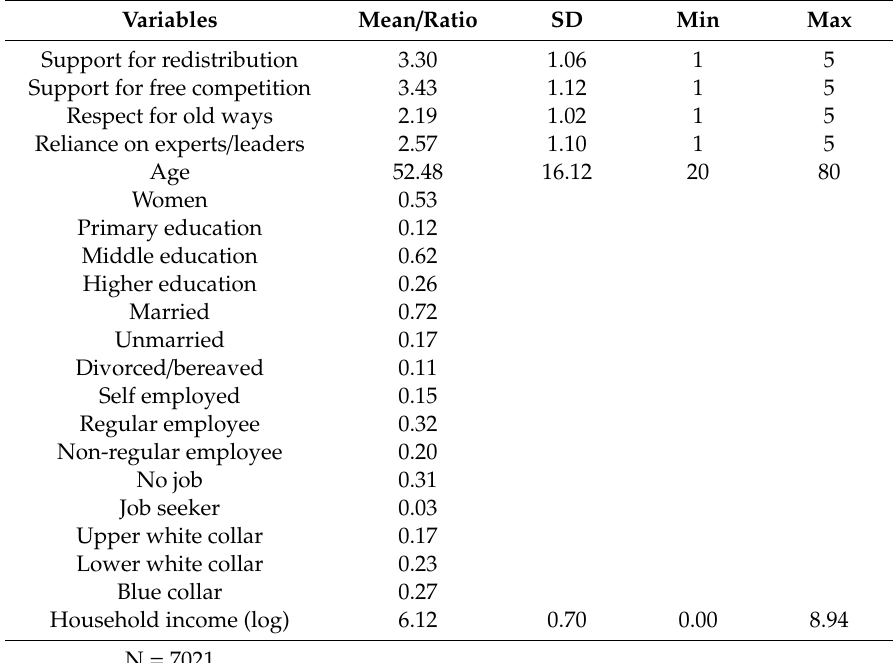
Table 1. Descriptive statistics